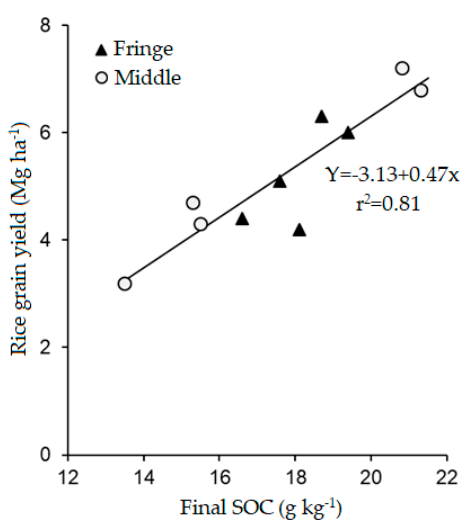
Figure 4. Relationship between final soil organic C and rice grain yield in 2018; y = − 3.13 + 0.47x, adjusted r² = 0.81, df = 8, p < 0.001; there was no significant interaction between position and the relationship between soil organic carbon (SOC) and rice grain yield.